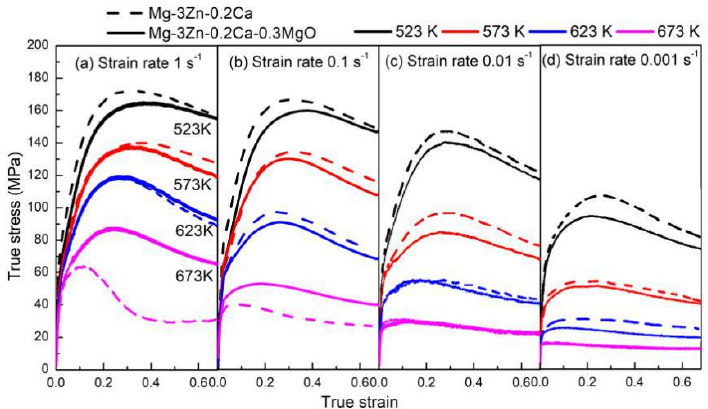
Figure 2. Ture stress-strain curves of MZC and MZCM at different temperatures with strain rates of ( a ) 0.001 s − 1 , ( b ) 0.01 s − 1 , ( c ) 0.1 s − 1 and ( d ) 1 s − 1 .